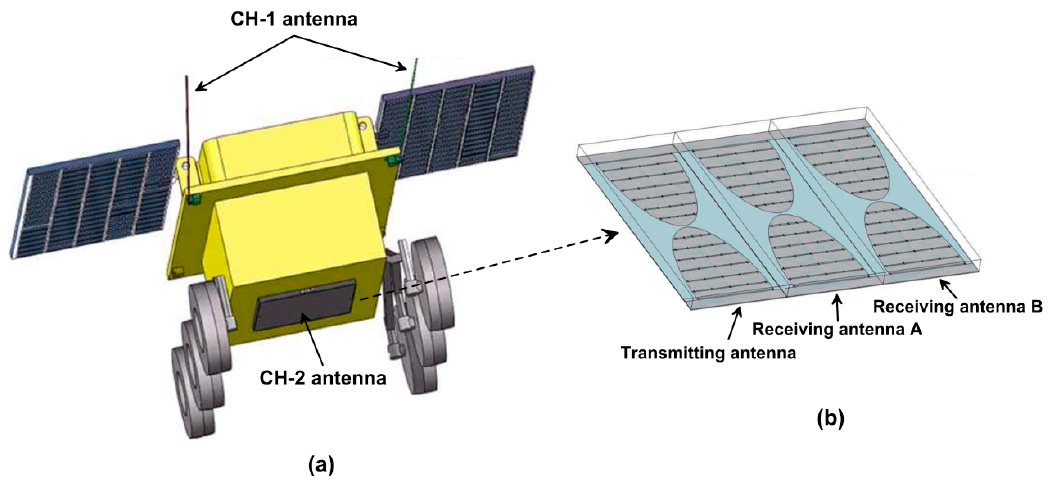
Figure 2. ( a ) The position of CH-2 antenna on the rover ( b ) The structure of the CH2 antenna.